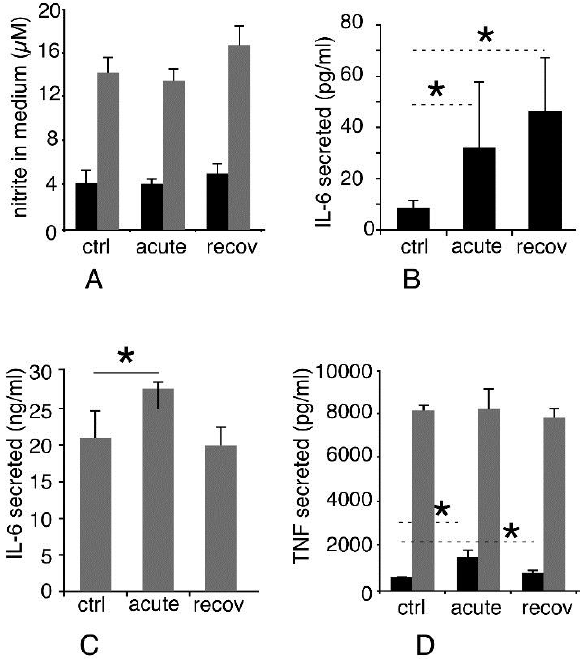
Figure 5. Inflammatory responses. The secretion of NO, interleukin-6, and TNF alpha was measured in response to pyrolytic silica, either alone or in combination with LPS. Ctrl: unexposed cells; acute: cells exposed to pyrolytic silica for 24 h and collected just after exposure; and recov: cells exposed to pyrolytic silica for 24 h and left to recover without silica for 72 h. ( A ) Production of nitric oxide. Black bars: production after treatment for 24 h with pyrolytic; grey bars: production after treatment for 24 h with pyrolytic silica and stimulation with LPS for the last 18 h of culture. ( B ) Production of interleukin-6 in the absence of LPS stimulation. ( C ) Production of interleukin-6 in the presence of LPS stimulation. ( D ) Production of TNF. Black bars: production after treatment for 24 h with pyrolytic silica; grey bars: production after treatment for 24 h with pyrolytic and stimulation with LPS for the last 18 h of culture. Symbols indicate the statistical significance (Mann–Whitney U-test): * p < 0.05.